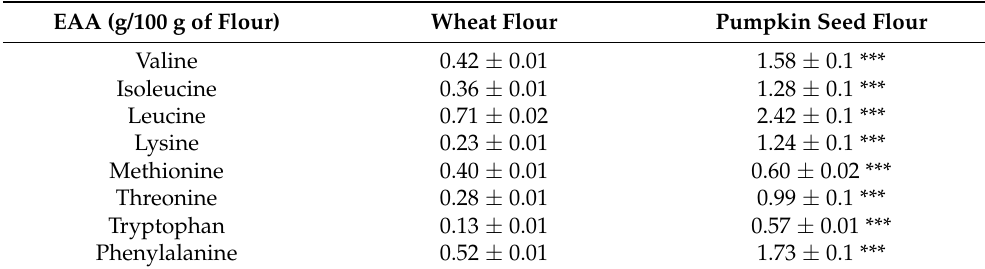
Table 2. The content of essential amino acids (EAA) in wheat flour and pumpkin seed flour. Data were compared with Student’s t -test ( p ≤ 0.05). Significance ***: p ≤ 0.001.